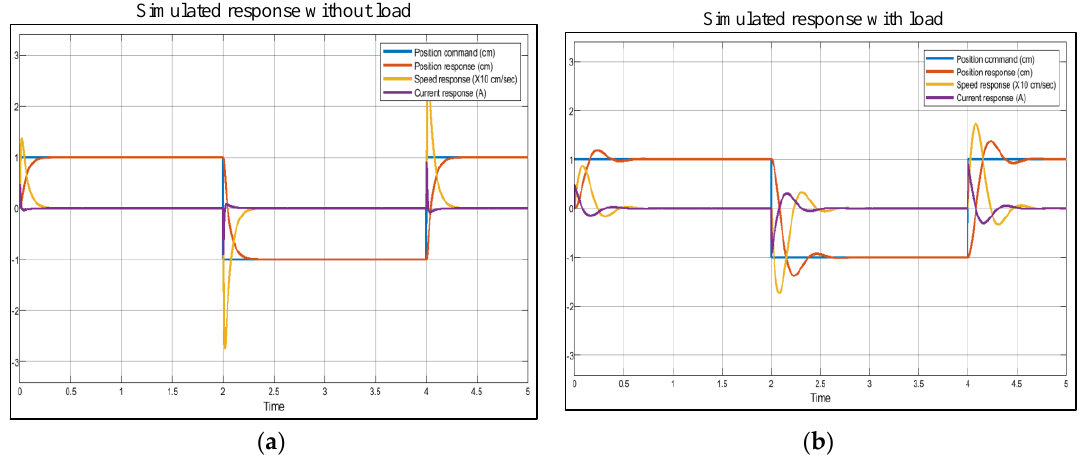
Figure 7. The simulation results of square wave position command. ( a ) No load condition. ( b ) With 4 kg load condition.